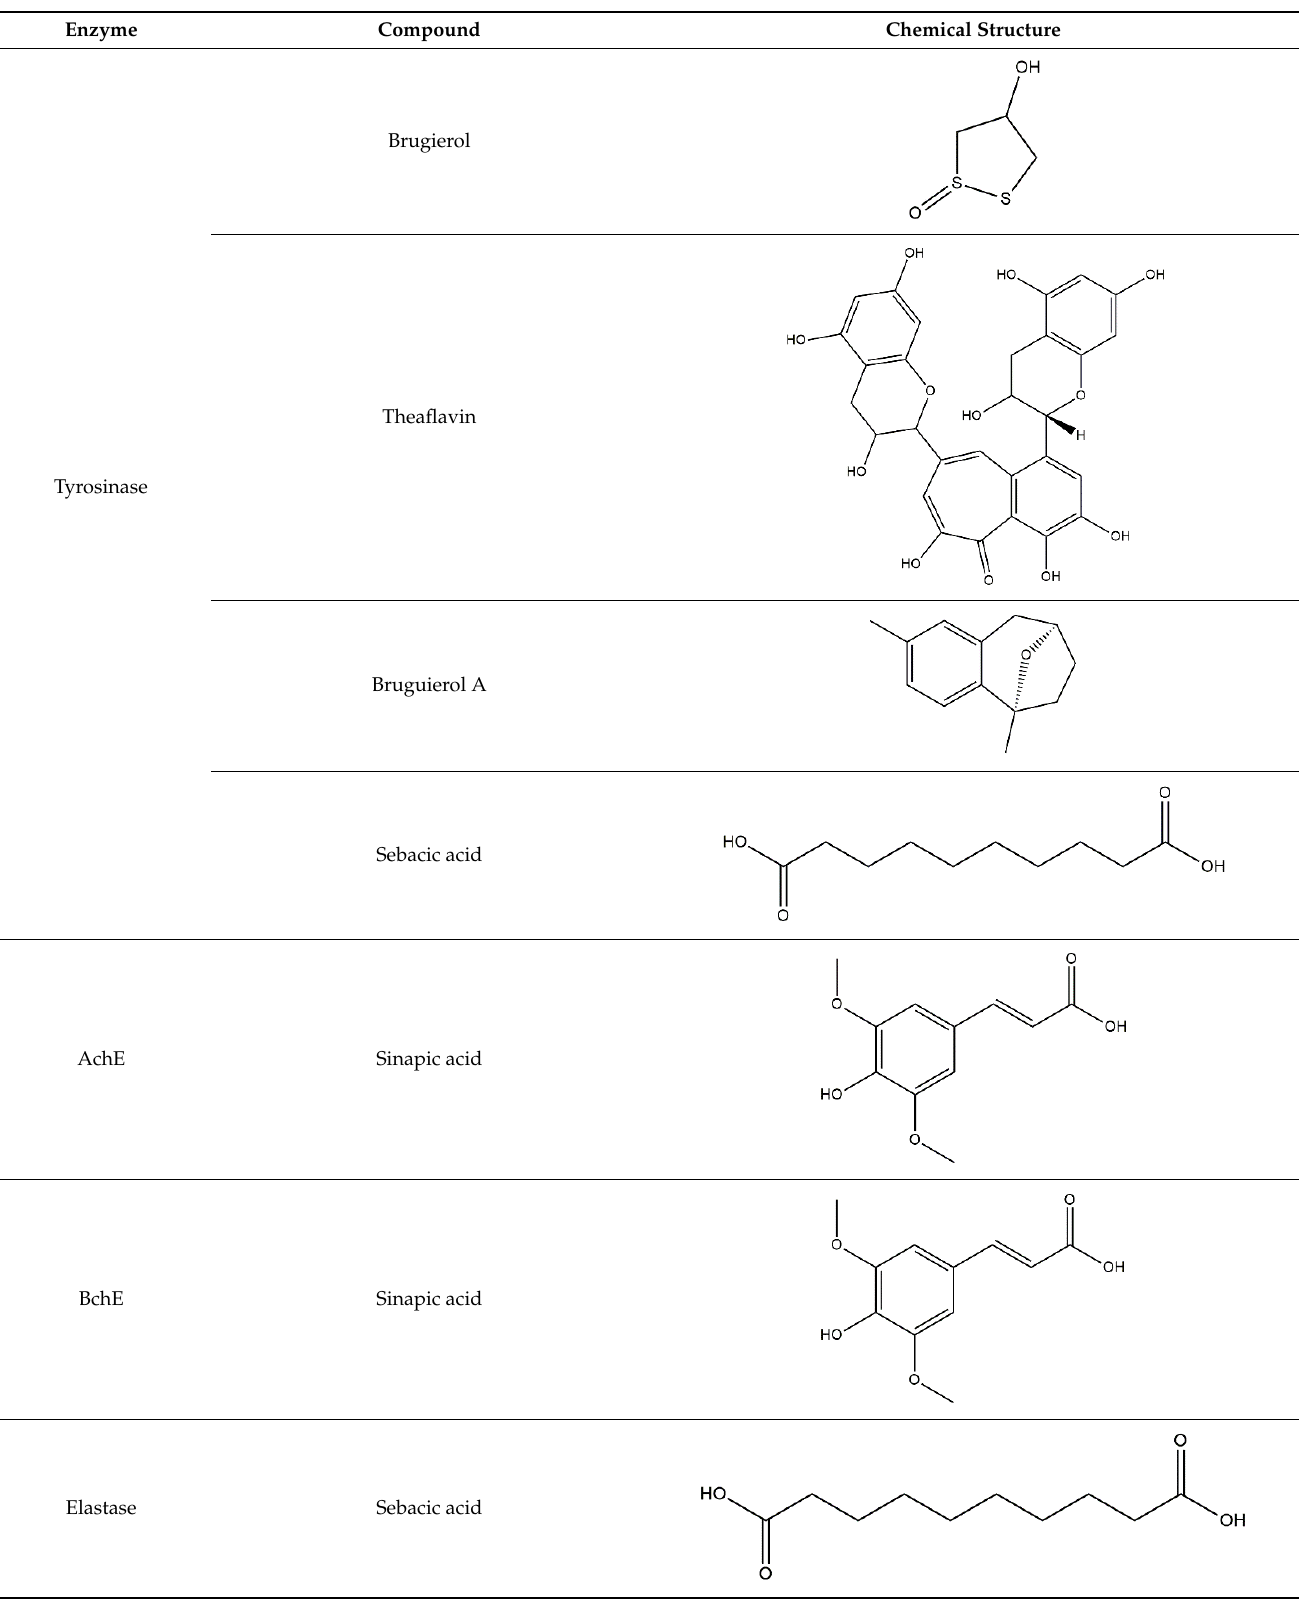
Table 8. Selected compounds and their corresponding enzymes for docking calculations.